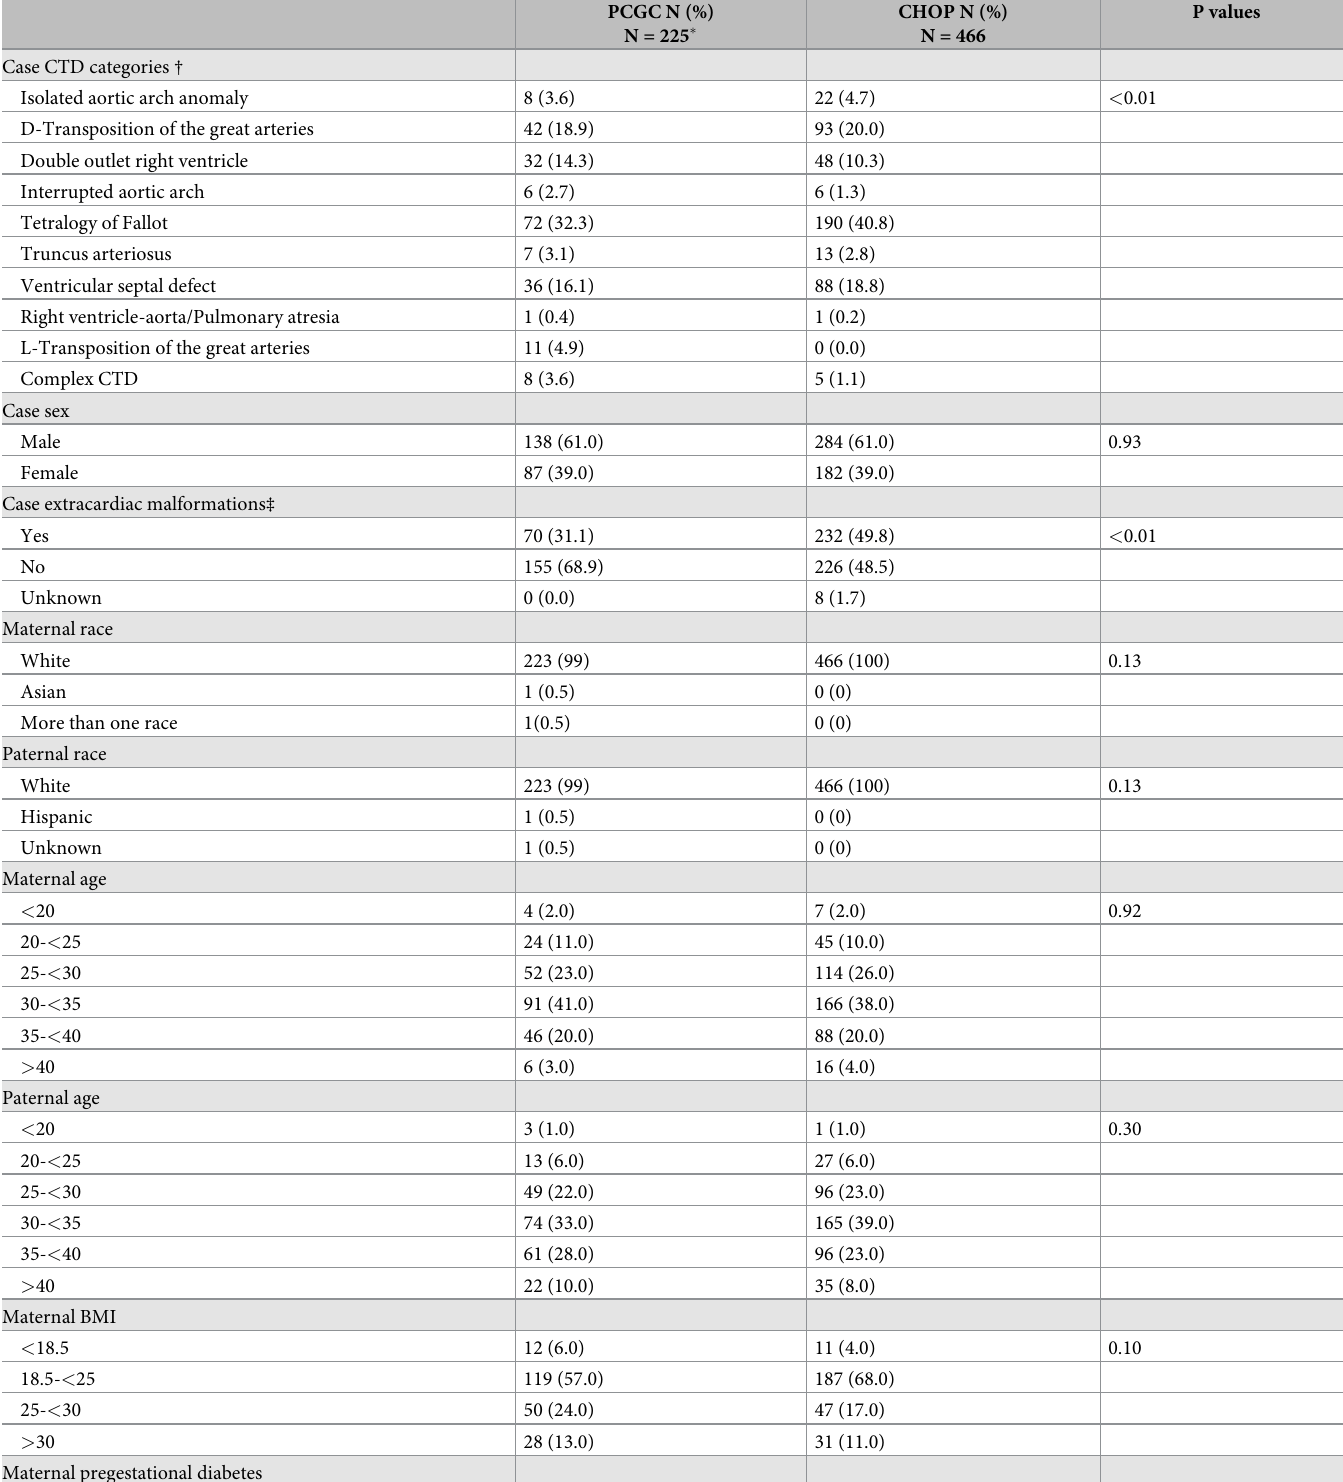
Table 1. Characteristics of conotruncal heart defect (CTD) cases and their parents in the CHOP and PCGC by study